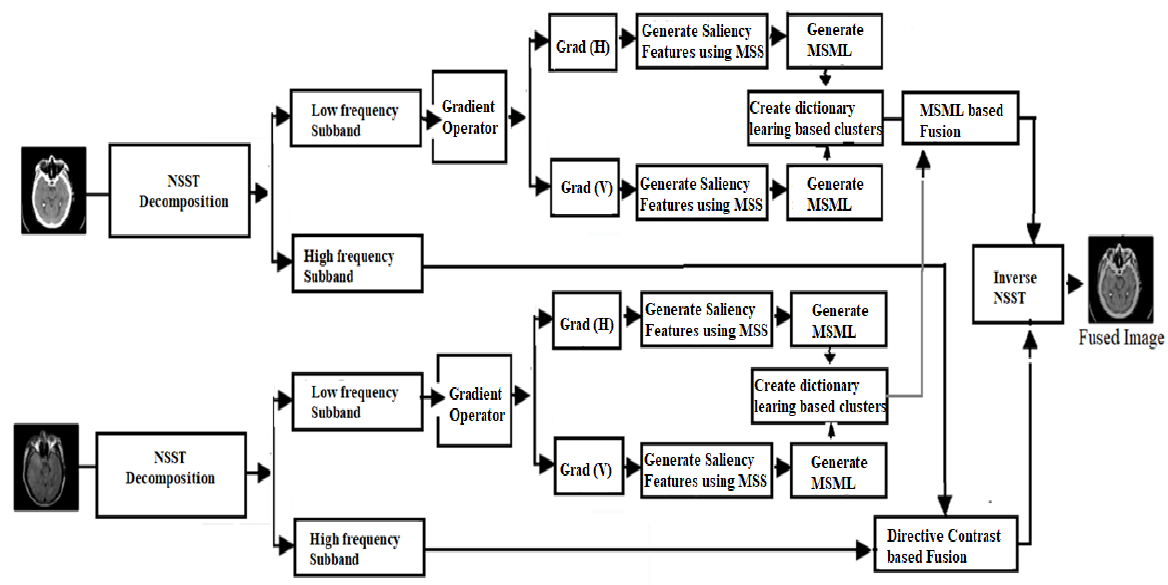
Figure 1. Multimodality medical image fusion proposed framework.